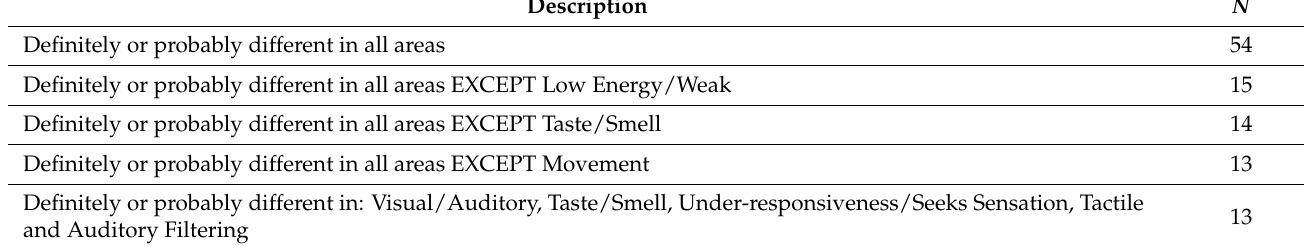
Table 1. 10 most common combinations of responses for the 7 sensory areas.